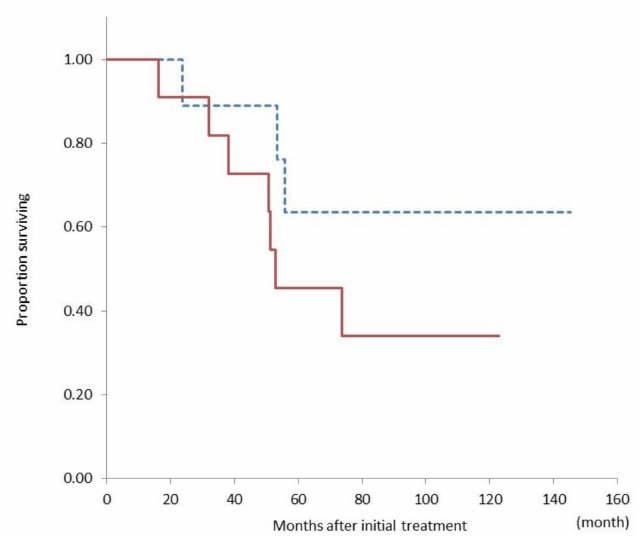
Figure 3. Comparison of the overall survival curves between patients with unresectable locally advanced cancer (dashed line, n = 9) and unresectable cancer with metastasis (solid line, n = 11) who underwent conversion surgery. There is no significant difference in overall survival between the groups ( p = 0.20).